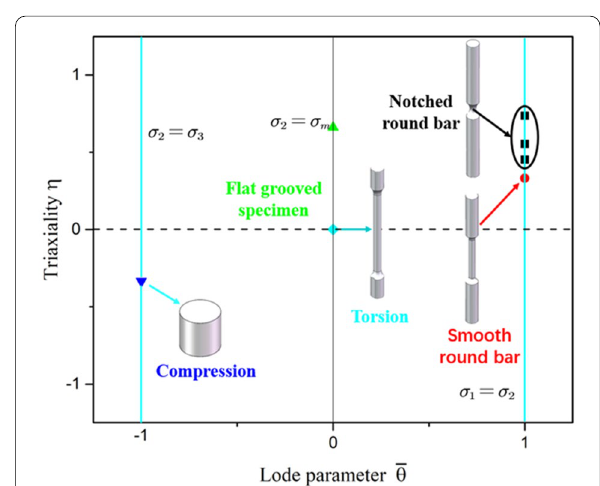
Figure 1 Experiments performed in the ST-LP space